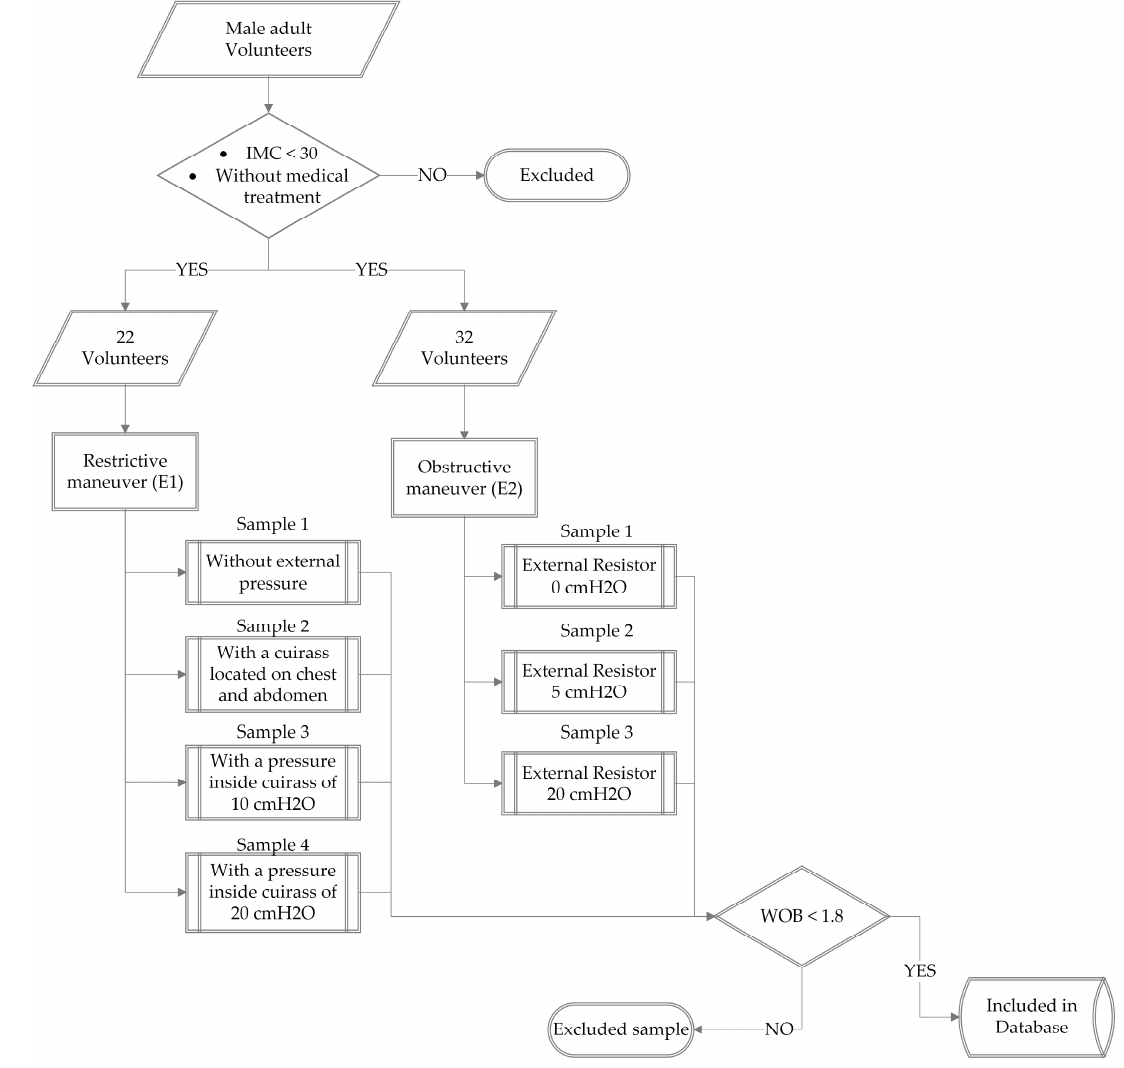
Figure 1. Experimental set-up. Two independent experiment were performed: in experiment 1 (E1), 22 volunteers were enrolled, and 4 samples per volunteer were obtained; and in experiment 2 (E2), 32 volunteers were enrolled, and 3 samples per volunteer were obtained.